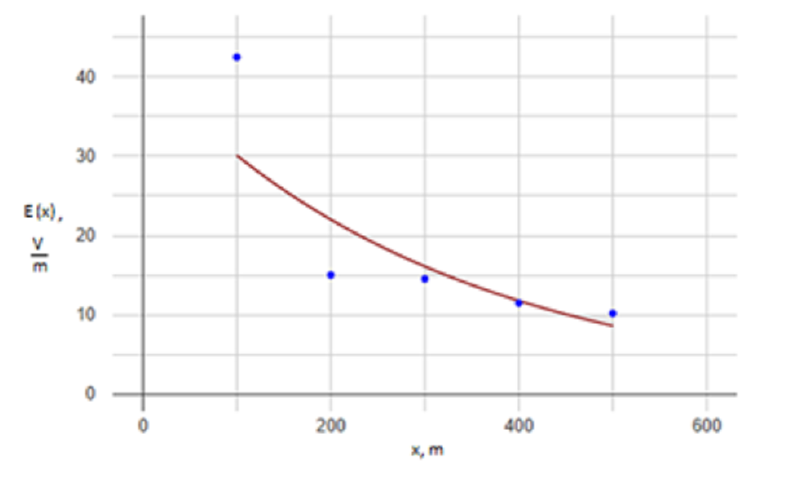
Fig. 9. Dependence of signal amplitude on the distance between the antennas. Signal frequency is 15 MHz